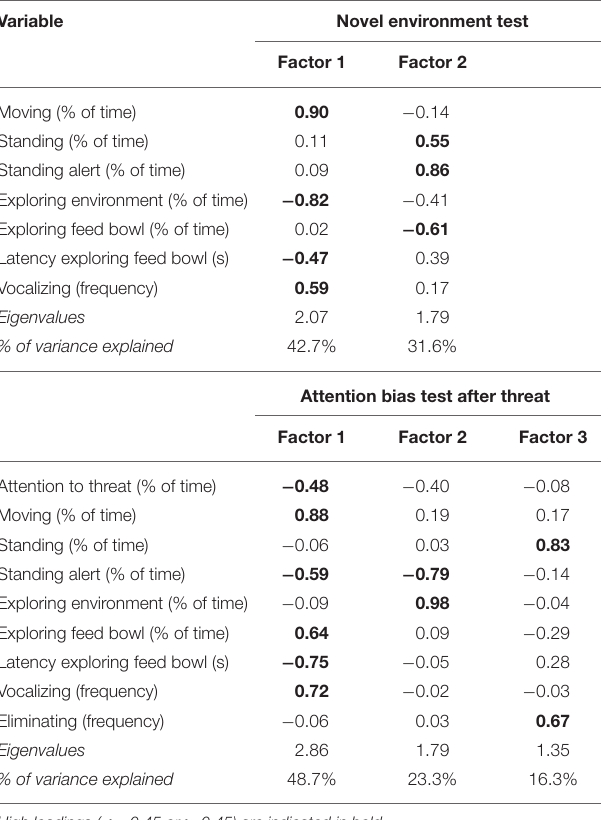
TABLE 4 | Loadings of the factors with an eigenvalue above one that were extracted by factor analysis with orthogonal Kaiser-Varimax rotation on the behaviors and attention scored during the novel environment test and the attention bias test during the 150s after the